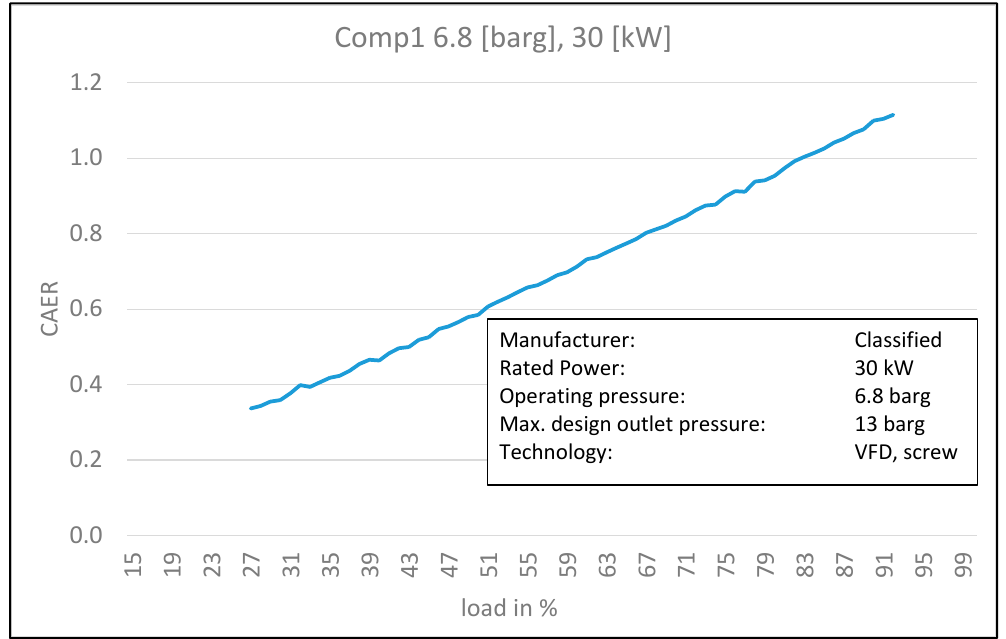
Figure 2. Electric power demand and percentage of maximum volume flow rate over time (source: own representation).